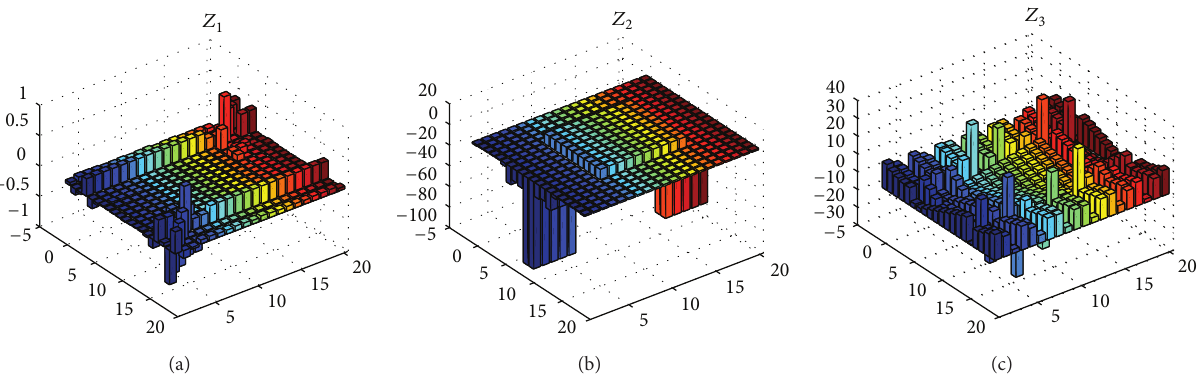
Figure 1: The bars graphs of 𝑍 𝑖 when 𝑟 = 20 .